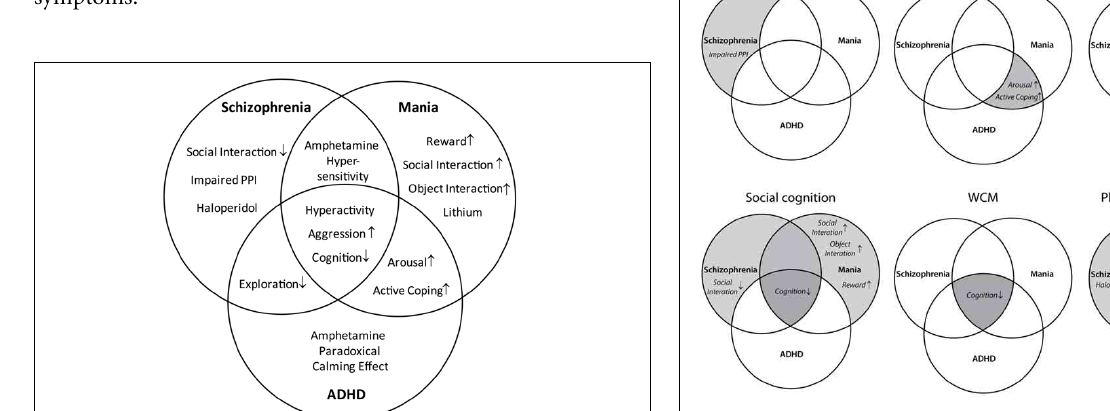
FIGURE 1 | Distinction and overlap of endophenotypes characteristic for schizophrenia, mania, and ADHD. The Venn diagram demonstrates the characteristic symptoms of schizophrenia, mania, and attention deficit hyperactivity disorder (ADHD), defined on the basis of DSM-IV. The overlapping areas indicate the common symptoms shared by the disorders.